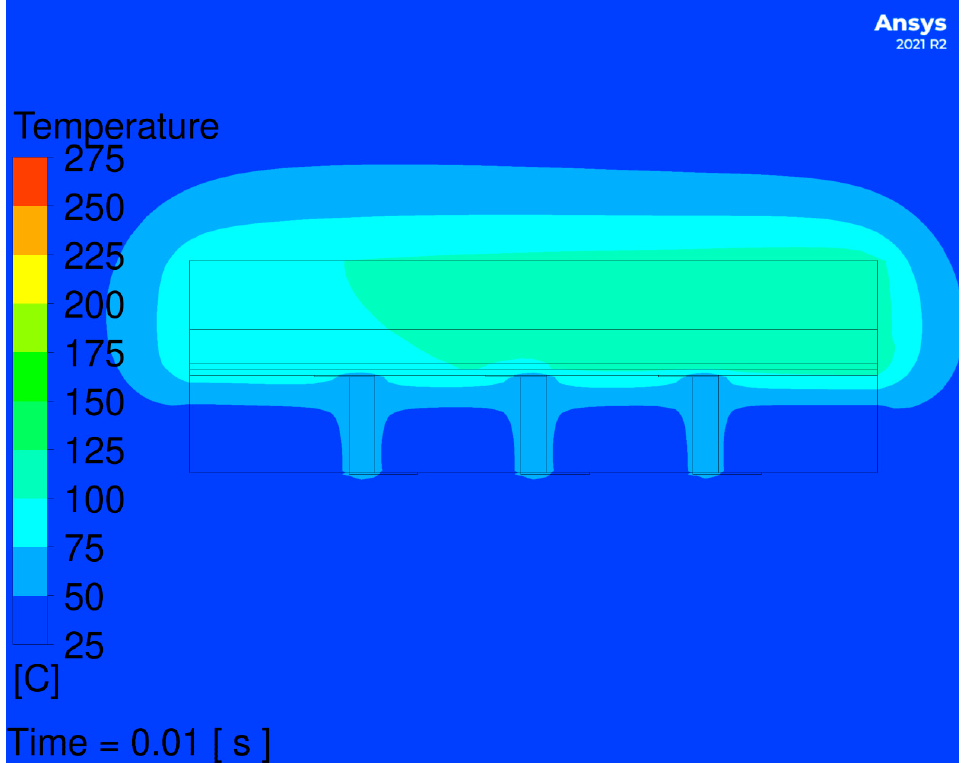
Figure 12. Temperature contours after 10